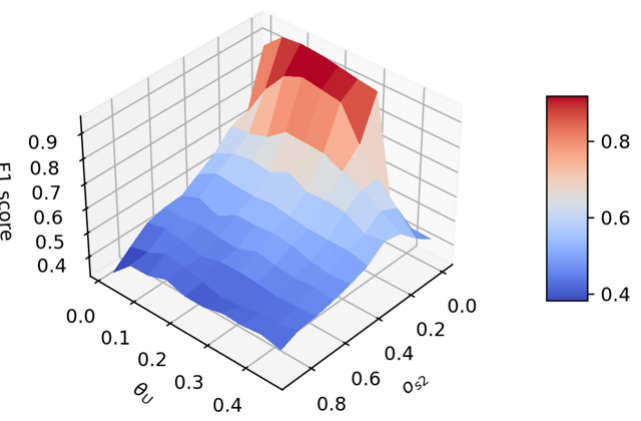
Figure 10. F1 score evaluating the intention inference accuracy with respect to simulation observation noise and the control term UUU ( i ) .